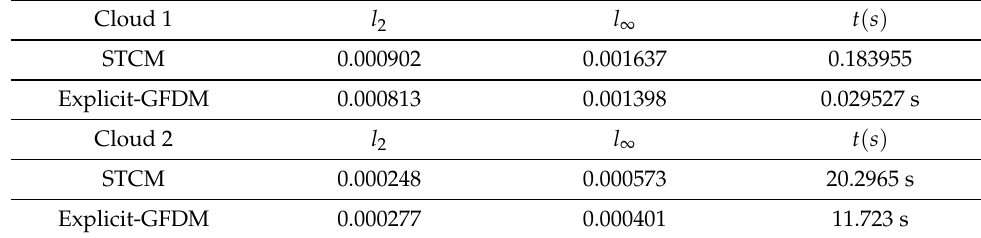
Table 1. Errors and execution time of the Example 1 in the clouds of Figures 3 and 4. Cloud 1